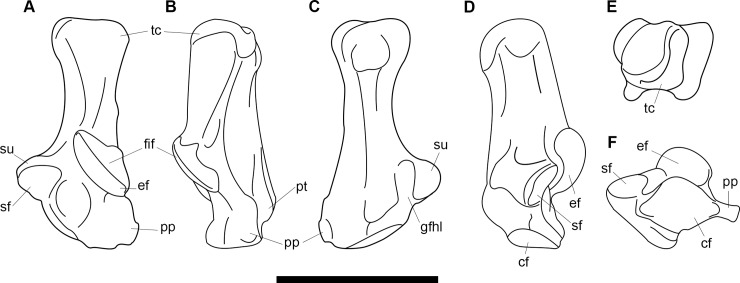
Annotated line drawing of the left calcaneum of Periptychus carinidens.(A) dorsal view; (B) lateral view; (C) plantar view; (D) medial view; (E) distal view, (F) anterior view. Abbreviations: cf, cuboid facet; ef, ectal facet; fif, fibular facet; gfhl, groove for the flexor hallucis longus tendon, pp, peroneal process; pt, plantar tubercle; sf, sustentacular facet; su, sustentaculum; tc, tuber calcanei. Scale bars: 30mm.